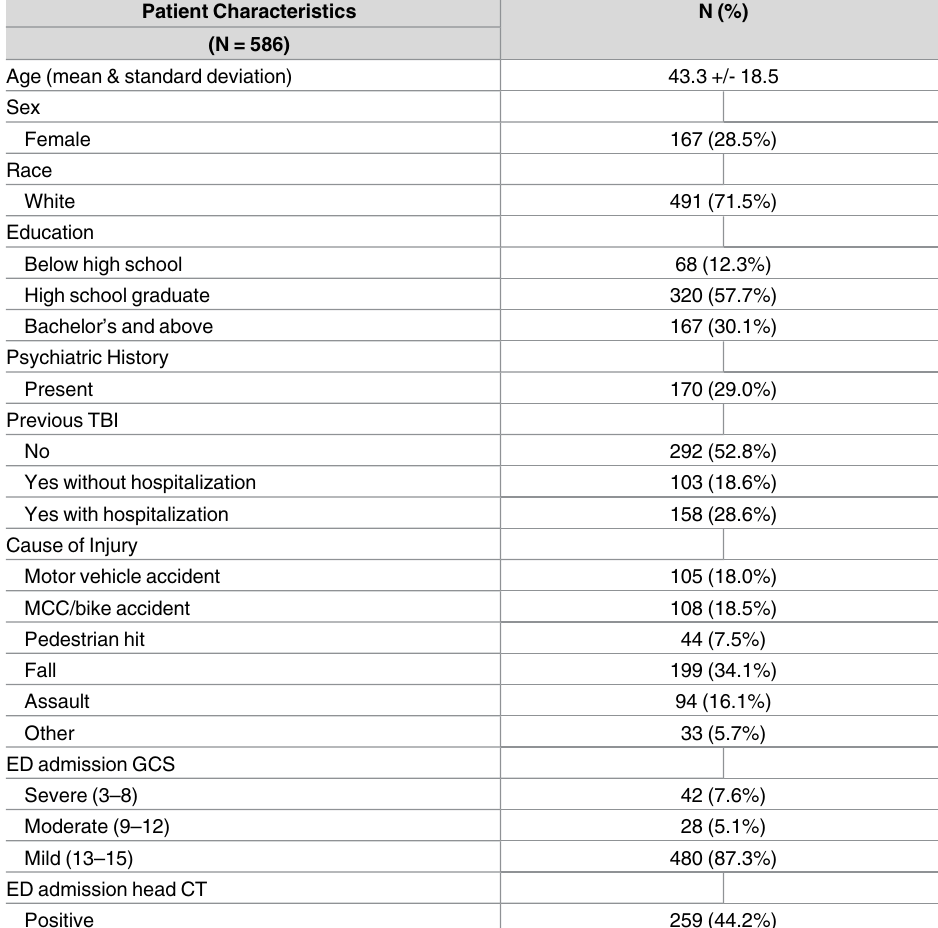
Table 1. Patient clinical characteristics. Patient